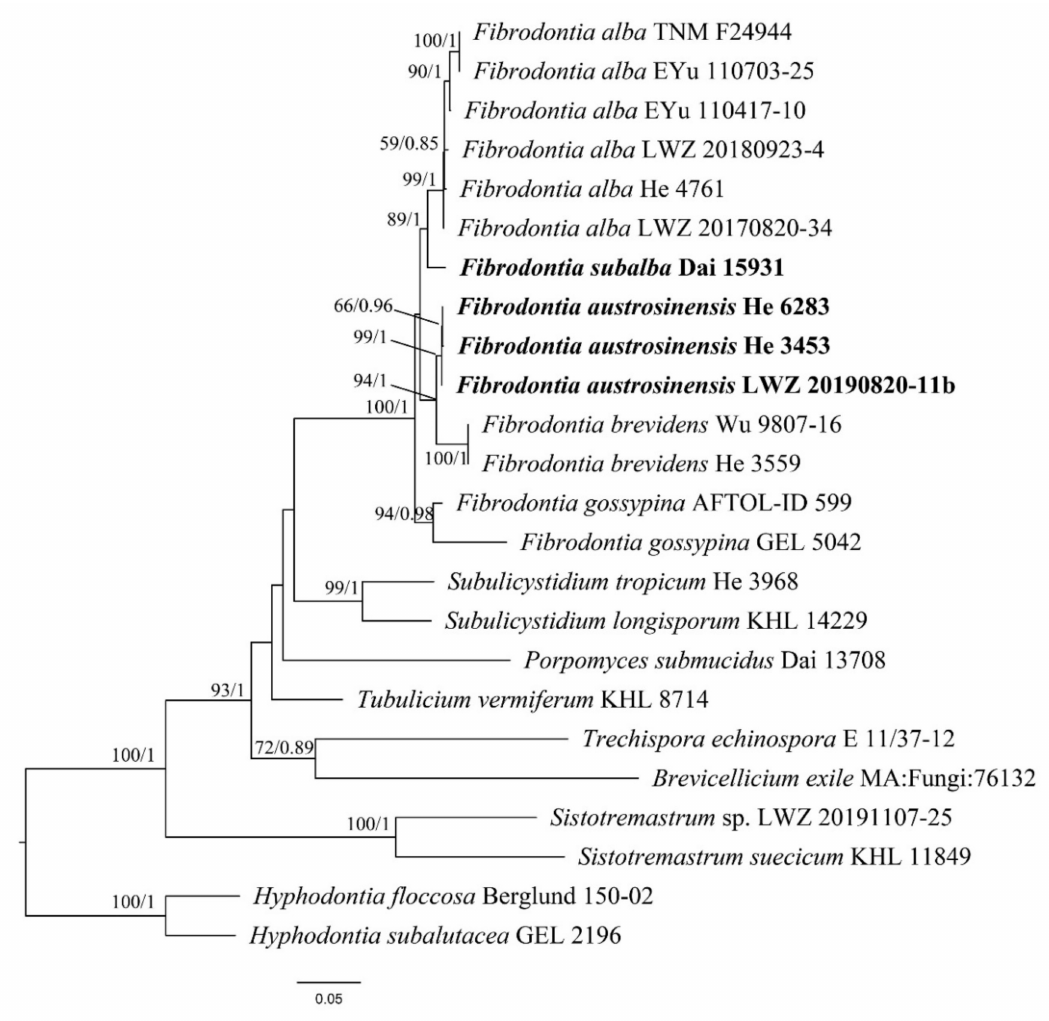
Figure 1. Phylogenetic position of Fibrodontia austrosinensis and F. subalba inferred from the data set of ITS and 28S region. The topology is from maximum likelihood analysis. Bootstrap values and Bayesian posterior probabilities, if simultaneously above 50% and 0.8, respectively, are labelled at the nodes. The newly described species are in